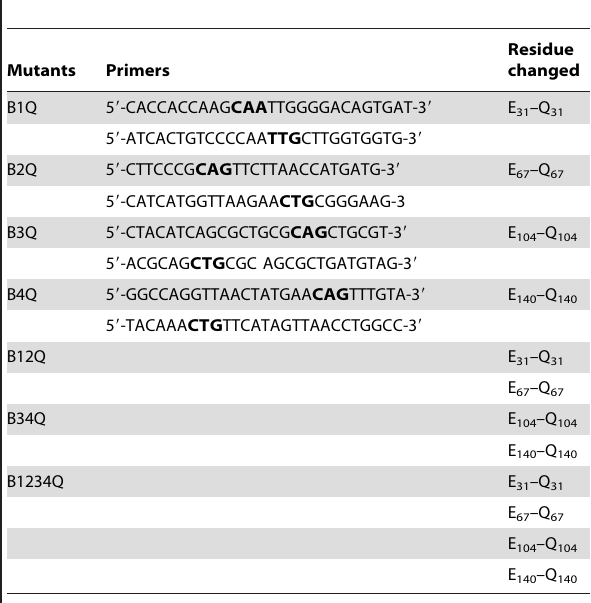
Table 1. The primers used for mutations and the residues changed for each